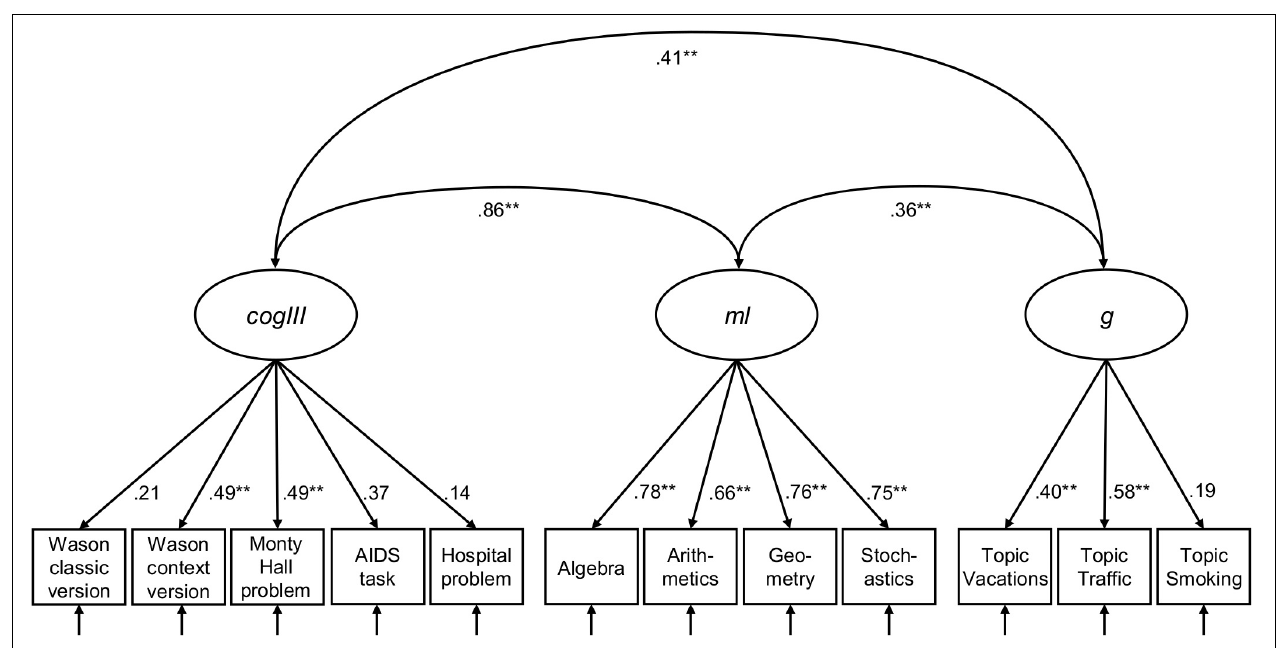
FIGURE A1 | Three-factor measurement model of cogIll , ml , and g. Model fit: N = 2,508, T [ χ 2 ] = 120.786, df = 51, p = 0.000, CFI = 0.986, TLI = 0.982, RMSEA = 0.023, SRMR = 0.036. The values display latent correlation or standardized coefficients, respectively. Values of χ 2 ≤ 3 df ( df = degrees of freedom), p ≥ 0.01, CFI (Comparative Fit Index) ≥ 0.95, TLI (Tucker-Lewis Index) ≥ 0.95, RMSEA (Root-Mean-Square Error of Approximation) ≤ 0.05, and SRMR (Standardized Root Mean Residual) ≤ 0.05 indicate a good model fit. cogIll : cognitive illusions, ml : mathematical literacy, g : general intelligence. *indicates p < 0.05; **indicates p < 0.01.